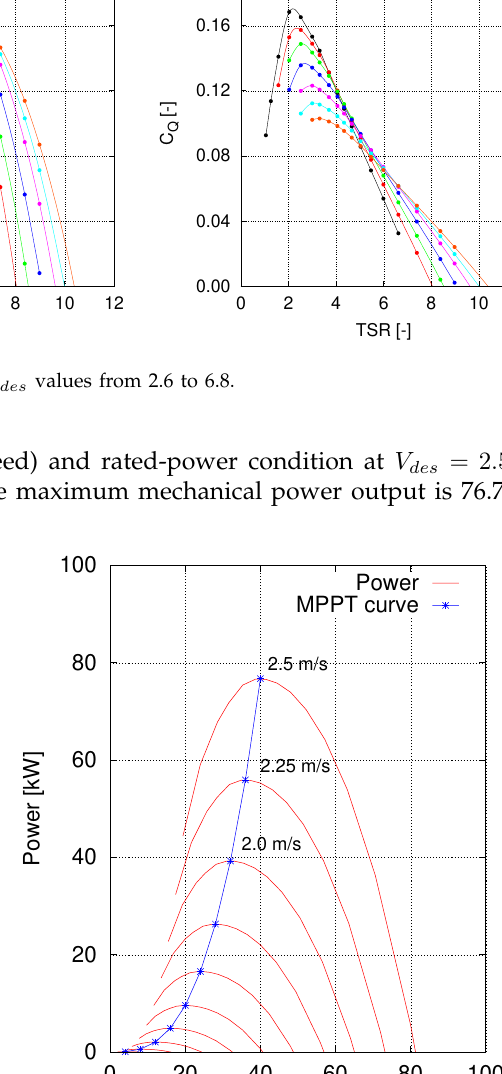
Fig. 25. Full-scale turbine, λ des = 3 . 5 : power-RPM curves as function of flow speed using a MPPT control ( V des = 2 . 5 m/s).